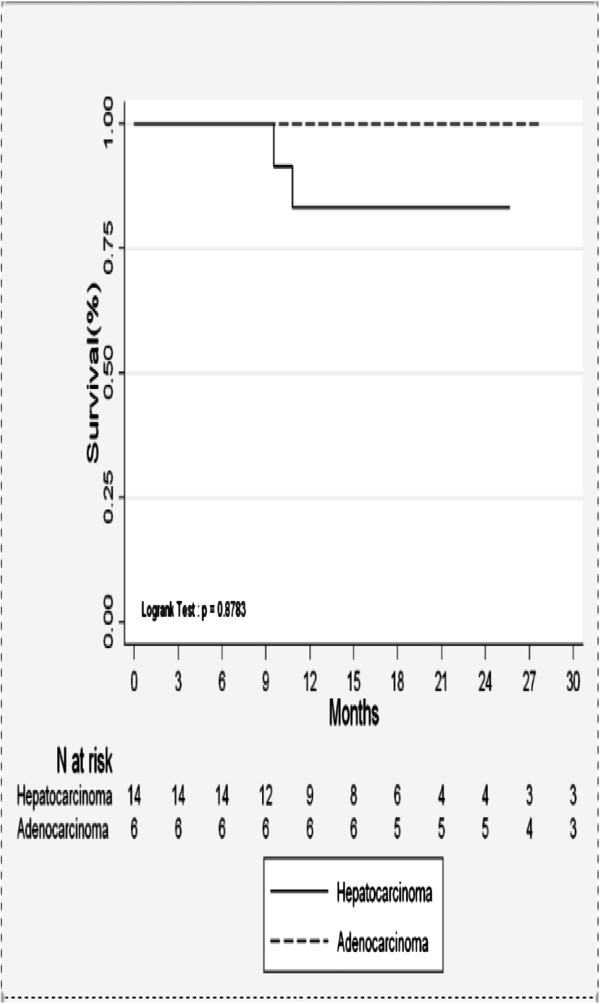
Overall survival.